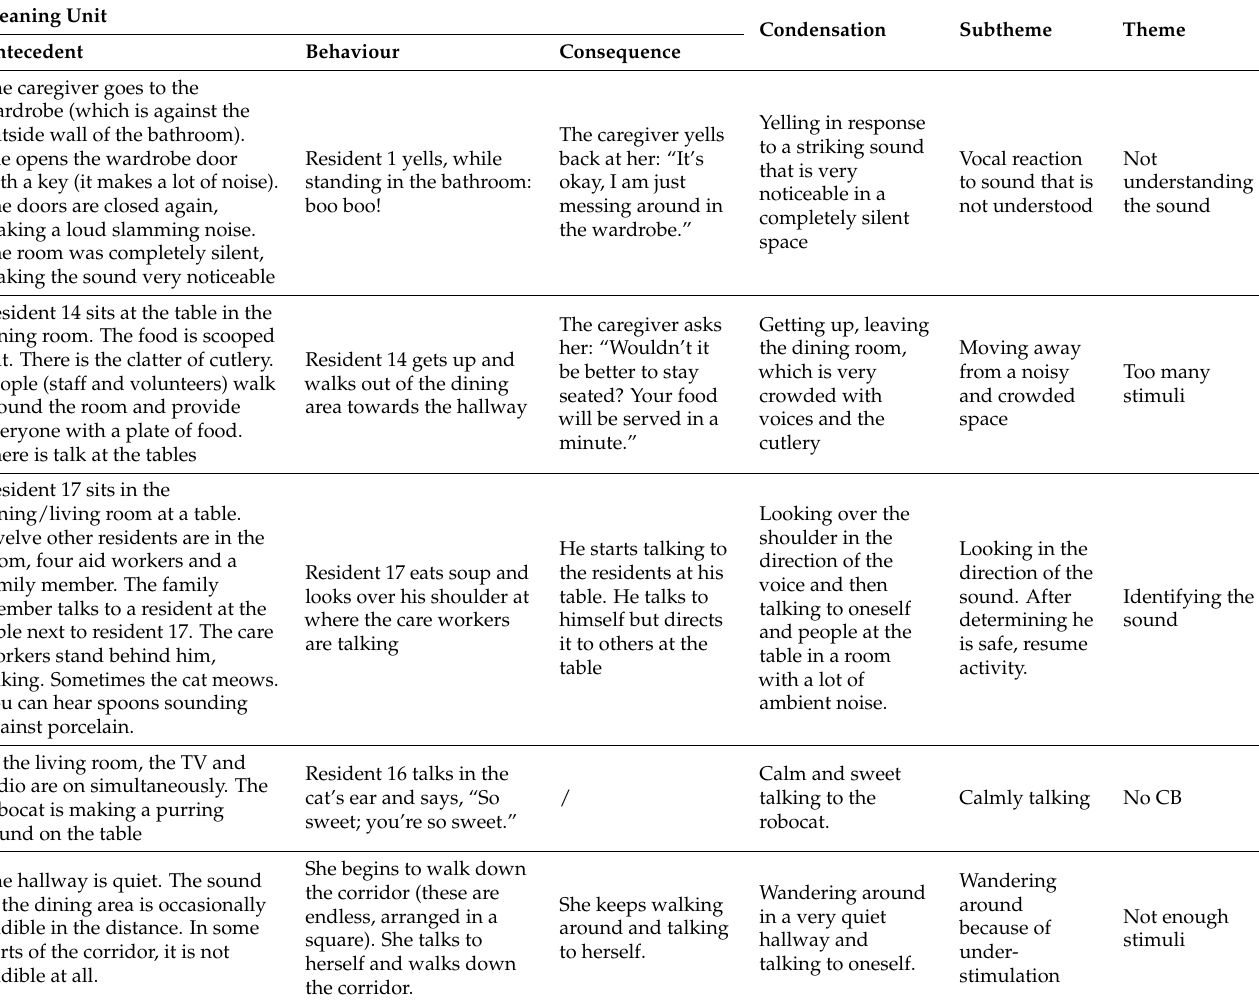
Table 2. Five meaning units of structural